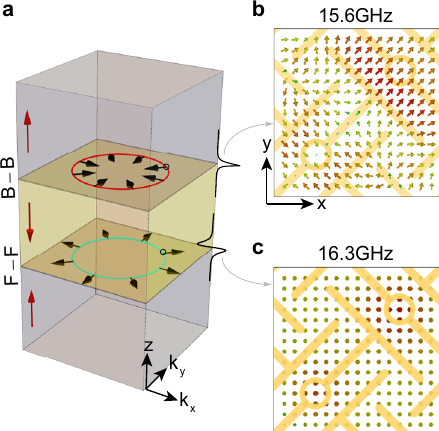
Fig. 4 Illustration of negative and positive refraction indices of domain wall states at the interfaces. a Two interfaces (Back – Back and Face – Face) formed by three metamaterials with different orientations indicated by red arrows. The Equi-Frequency Contour (EFC) exhibits negative/positive refraction index of the Back – Back(B – B)/Face – Face(F – F) domain wall state, with group velocity opposite/along the direction of the wave vector. The black arrows indicate group velocity directions. b , c Electric fi eld distribution of the Back – Back/Face – Face interface state right at the interface. There are only in-plane components in the longitudinal interface mode ( b ) and out- plane components in the transverse interface mode ( c ), respectively. The corresponding wavevectors are indicated by hollow dots in a